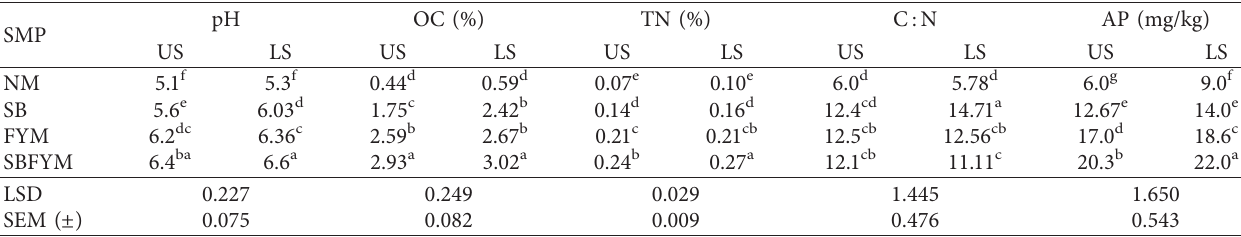
Table 5: Interaction effect of soil management practices and slope ranges on chemical properties of soils in Mawula